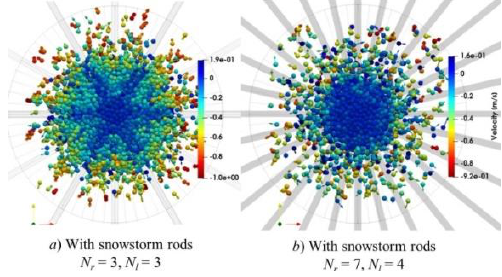
Fig. 6. Vertical p article velocity for different arrangements